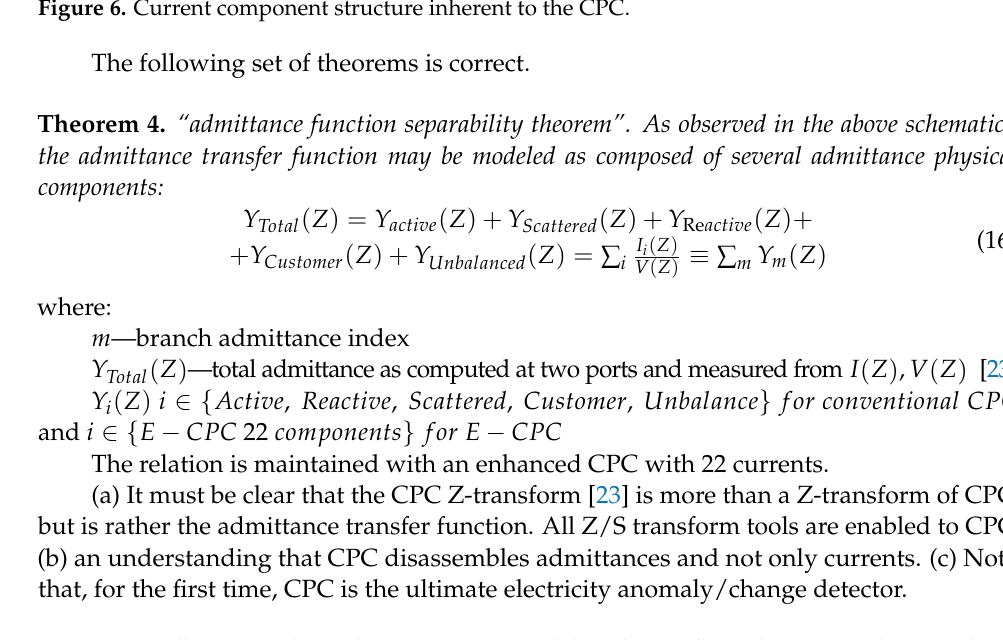
Figure 6. Current component structure inherent to the